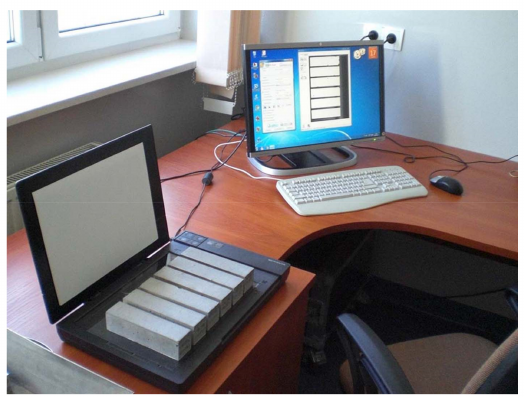
Figure 1. Test stand for scanning the surface of cement paste.